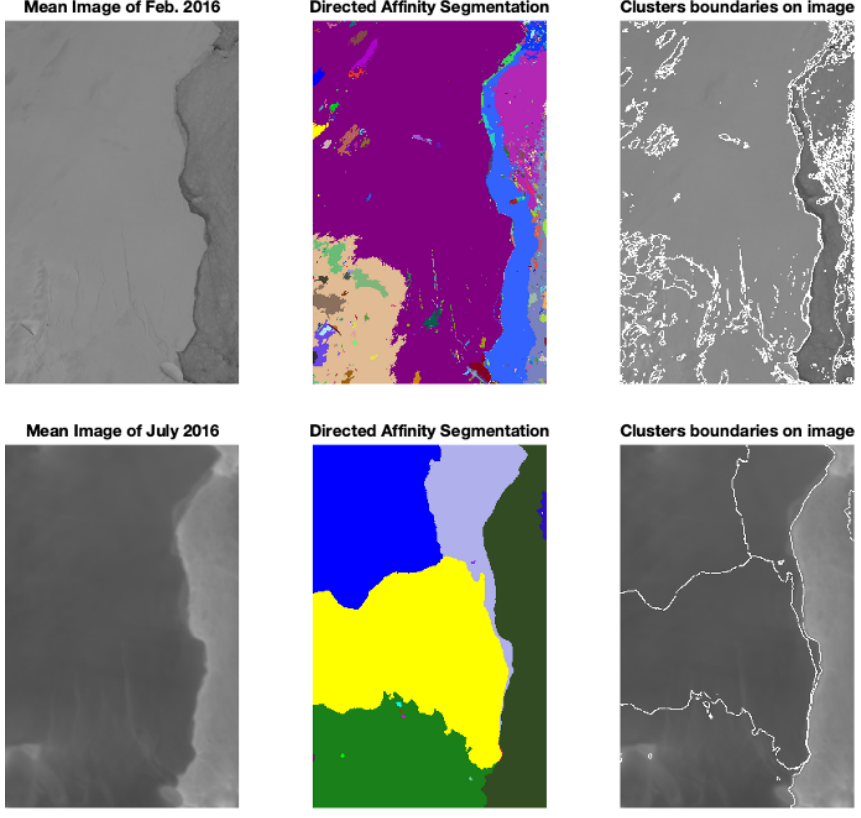
Figure 6. For two time windows (top and bottom), we see the mean image (left) of the images included in the window, the DAS labeled clusters (middle) and the overlay of the DAS boundaries (right) over the mean image of the window. We took these two time windows from February and July 2016 as a detailed example, and more time window results are shown in Fig. 7. During 2016, there was no significant change in the Larsen C crack at the beginning of the year. However, in July 2016, based solely on data up to that point in time, the DAS proposed a large change in the crack dynamics, and this change continued faster, as Fig. 7 shows. Raw images sourced from Scambos et al. (1996).